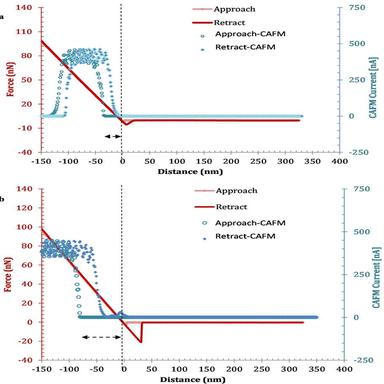
(a) 3D CAFM deflection image of the hollow conductive pattern of single gold nanorods (b) corresponding CAFM current mapping (c) typical 2D representation of deflection image of type I conductive patten (d) shows 2D tapping mode image of a nanorod and corresponding 3D presentation of larger image (e, f) to illustrate up and down (concave shape) on the top surface morphology of single nanorod imaged by T-mode and compare it with CAFM C-mode in (c) and (f).